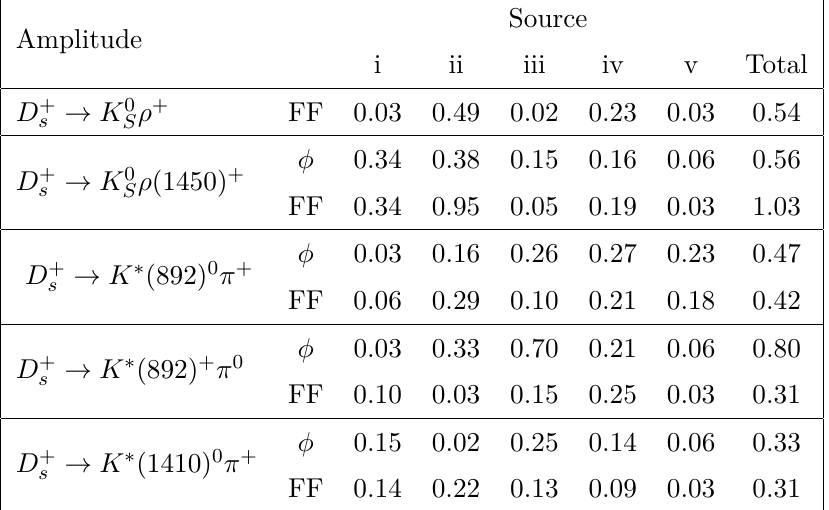
Table 6 . Systematic uncertainties on the φ and FFs for each amplitude in units of the corresponding statistical uncertainties. The sources are: (i) Fixed parameters in the amplitudes, (ii) The R values, (iii) Background, (iv) Experimental effects, (v) Fit